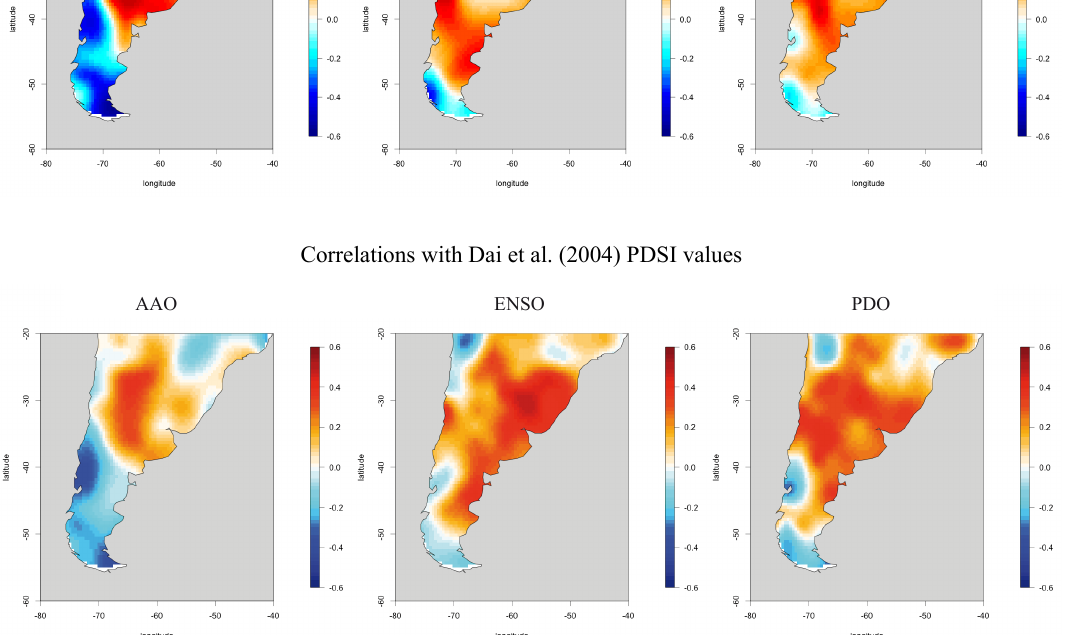
Fig. 14. Correlations of reconstructed (upper panel) and Dai et al. (2004) (lower panel) summer PDSI with the main ocean-atmosphere indices: AAO, ENSO, and PDO. All correlations were computed on the common 1950–1993 period.